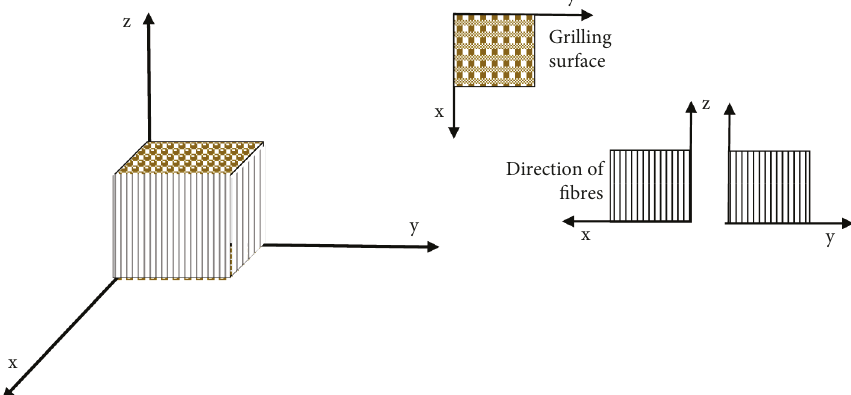
Figure 1: Orthogonal isometric view of the 3D model of cubic meat pieces with defined grilling